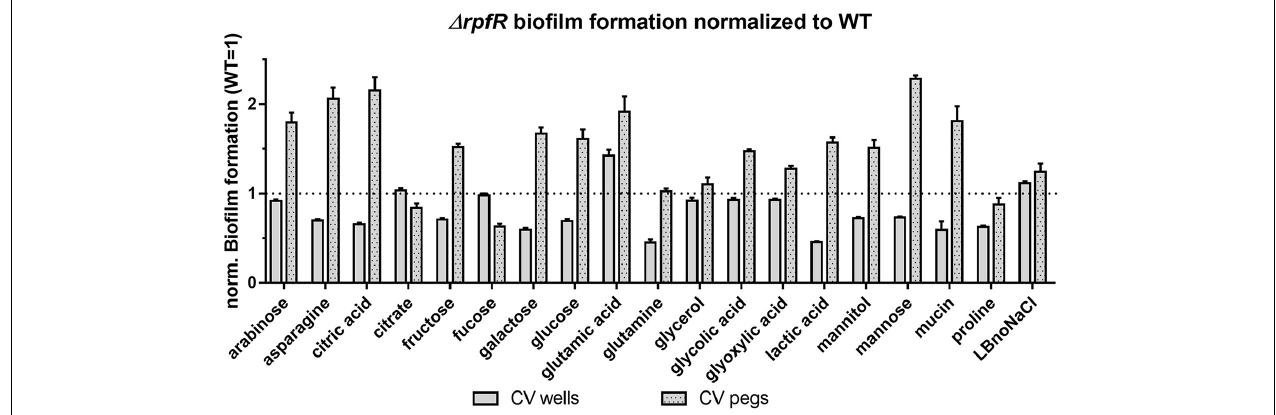
FIGURE 5 | Biofilm formation in microtiter plates by the B. cenocepacia rpfR mutant under various medium conditions. Cells were grown in ABnoNaCl supplemented with carbon sources as indicated (see material and methods for concentrations) under static conditions at 37 ◦ C for 24 h. Subsequently, the amount of biofilm on the wells and on the pegs, respectively, was determined via a CV staining assay. Graphs show OD 590nm values of CV bound by the (cid:49) rpfR mutant normalized to values obtained from the wild type. Error bars indicate standard deviations of 4 replicates per strain, and data shown here are representatives of three independent experiments.